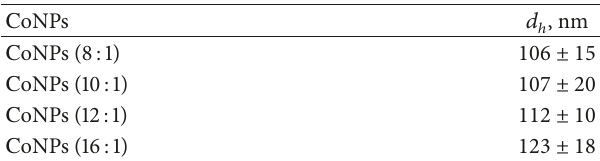
Table 2: Hydrodynamic diameter ( 𝑑 ℎ ) from NTA measurements of nanoparticles b oNPs in aqueous